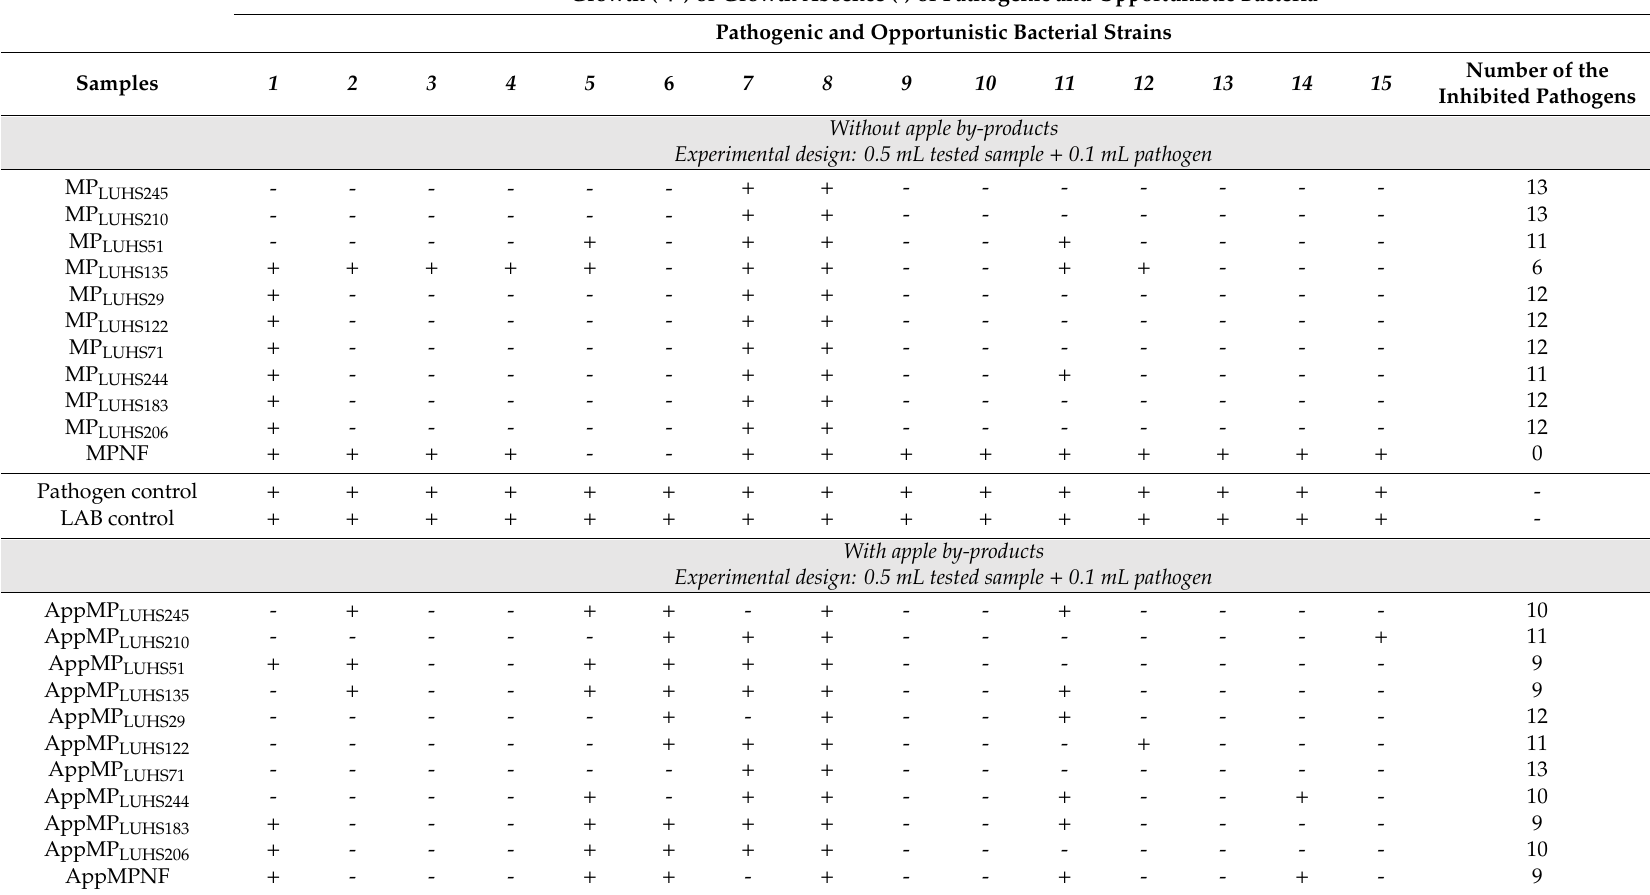
Table 3. Average values and standard deviations (Mean ± STDV) ( n = 3) of the antimicrobial activities in the milk permeate (MP) (0 h) and final fermented beverages (24 h), without and with addition of apple by-products, against 15 pathogenic and opportunistic microbial bacterial in liquid medium ( + indicates pathogen growth; - indicates that pathogen growth was not